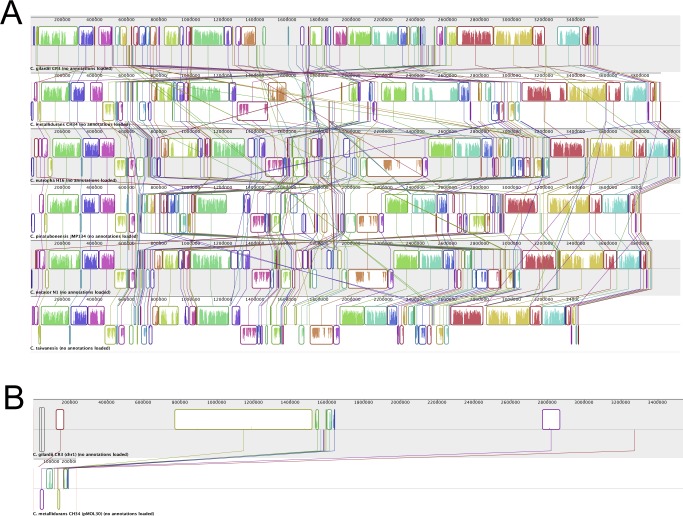
Synteny plot analysis of Cupriavidus replicons.(A) Synteny plot analysis of Chr1 from C. galardii CR3 and from 5 other finished Cupriavidus strains; (B) Synteny plot analysis of Chr 1 from C. galardii CR3 and pMOL30 from C. metallidurans CH34.